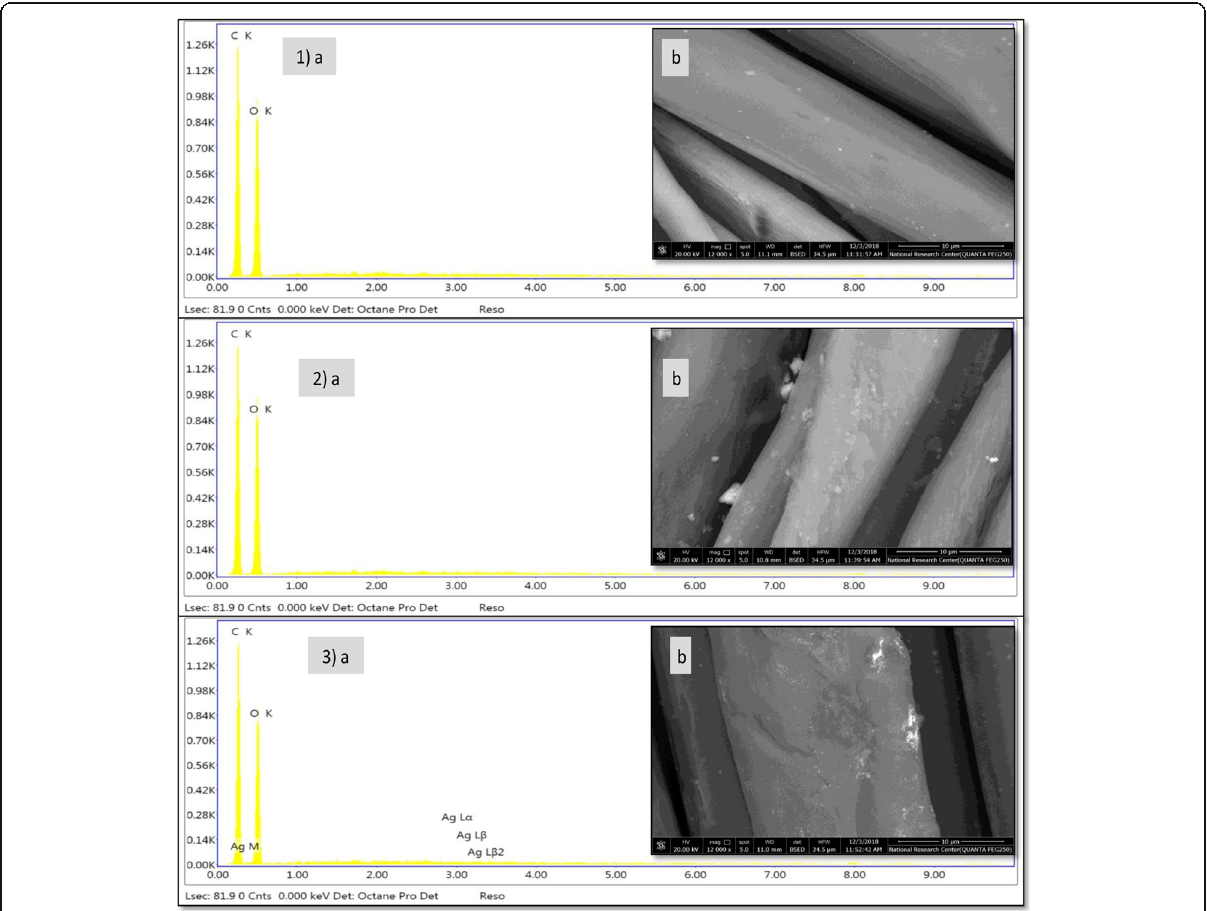
Fig. 8 EDAX analysis (a) and SEM micrographs (b) of the PET/C textile treated with AgNPs biosynthesized by means of A. fumigatus CFF mediation. 1, Blank PET/C (not treated); 2, PET/C Control (treated with CFF); and 3, treated with biosynthesized